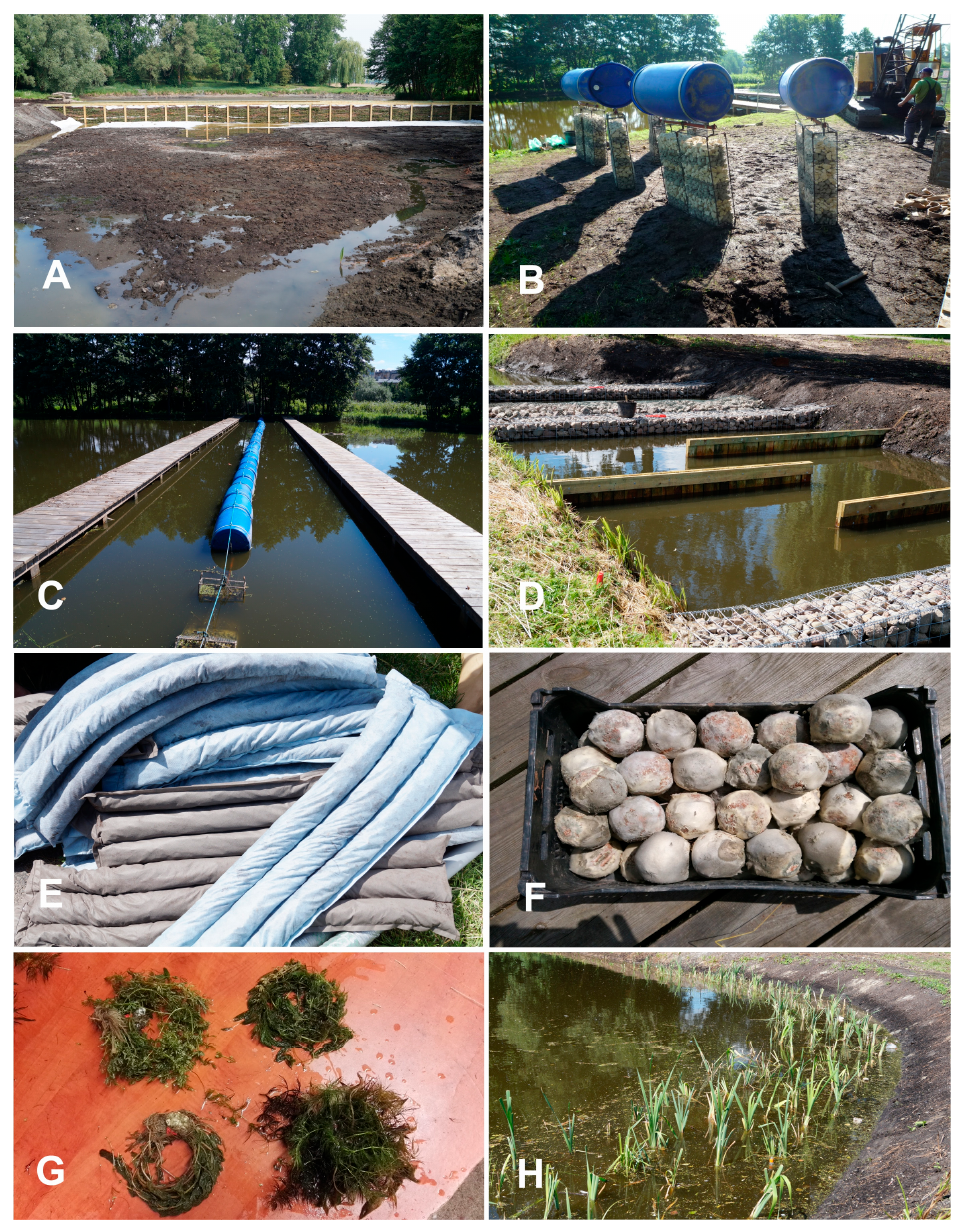
Figure 4. Structural and biotic elements of the SED-BIO system: ( A )—a wicker gabion on a drained pond (section A); ( B )—floats with a mineral filter, ( C )—two wicker gabions with a mineral filter between them (section A); ( D )—view of section B; ( E )—specially prepared mattresses with denitrification deposit; ( F )—Micro-Dictum preparation; ( G )—wreaths of submerged plants specially prepared for planting; ( H )—planted Typha and Glyceria in the littoral zone (section A).